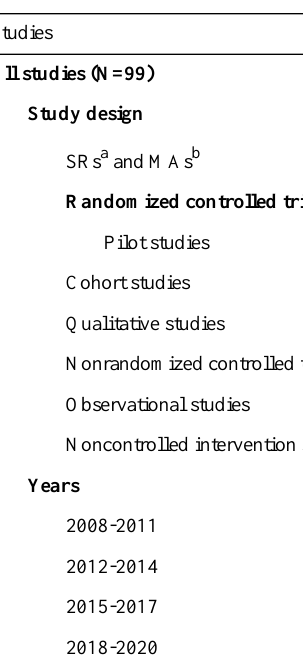
Table 1. Baseline characteristics of reviewed studies.